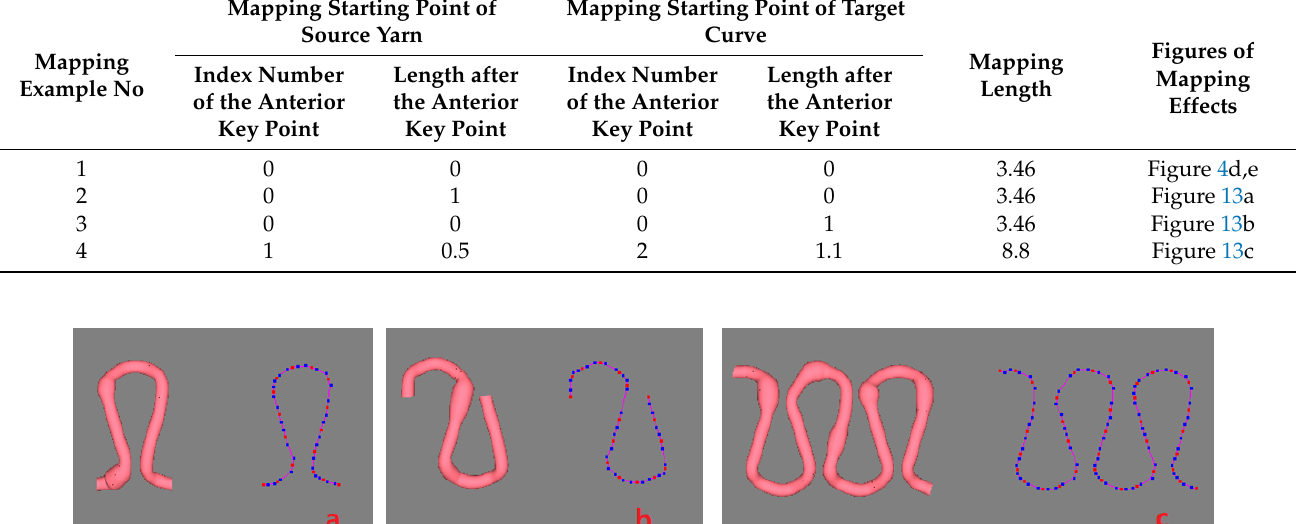
Table 2. Mapping parameters of the examples.